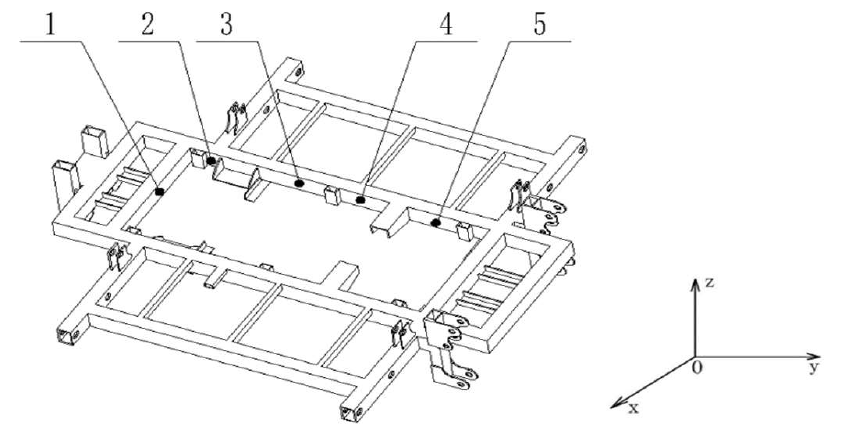
Figure 6. Position on the frame for vibration testing. Points 1–5 are the positions of the five measurement points. Table 3. Performance parameters of vibration test instruments.